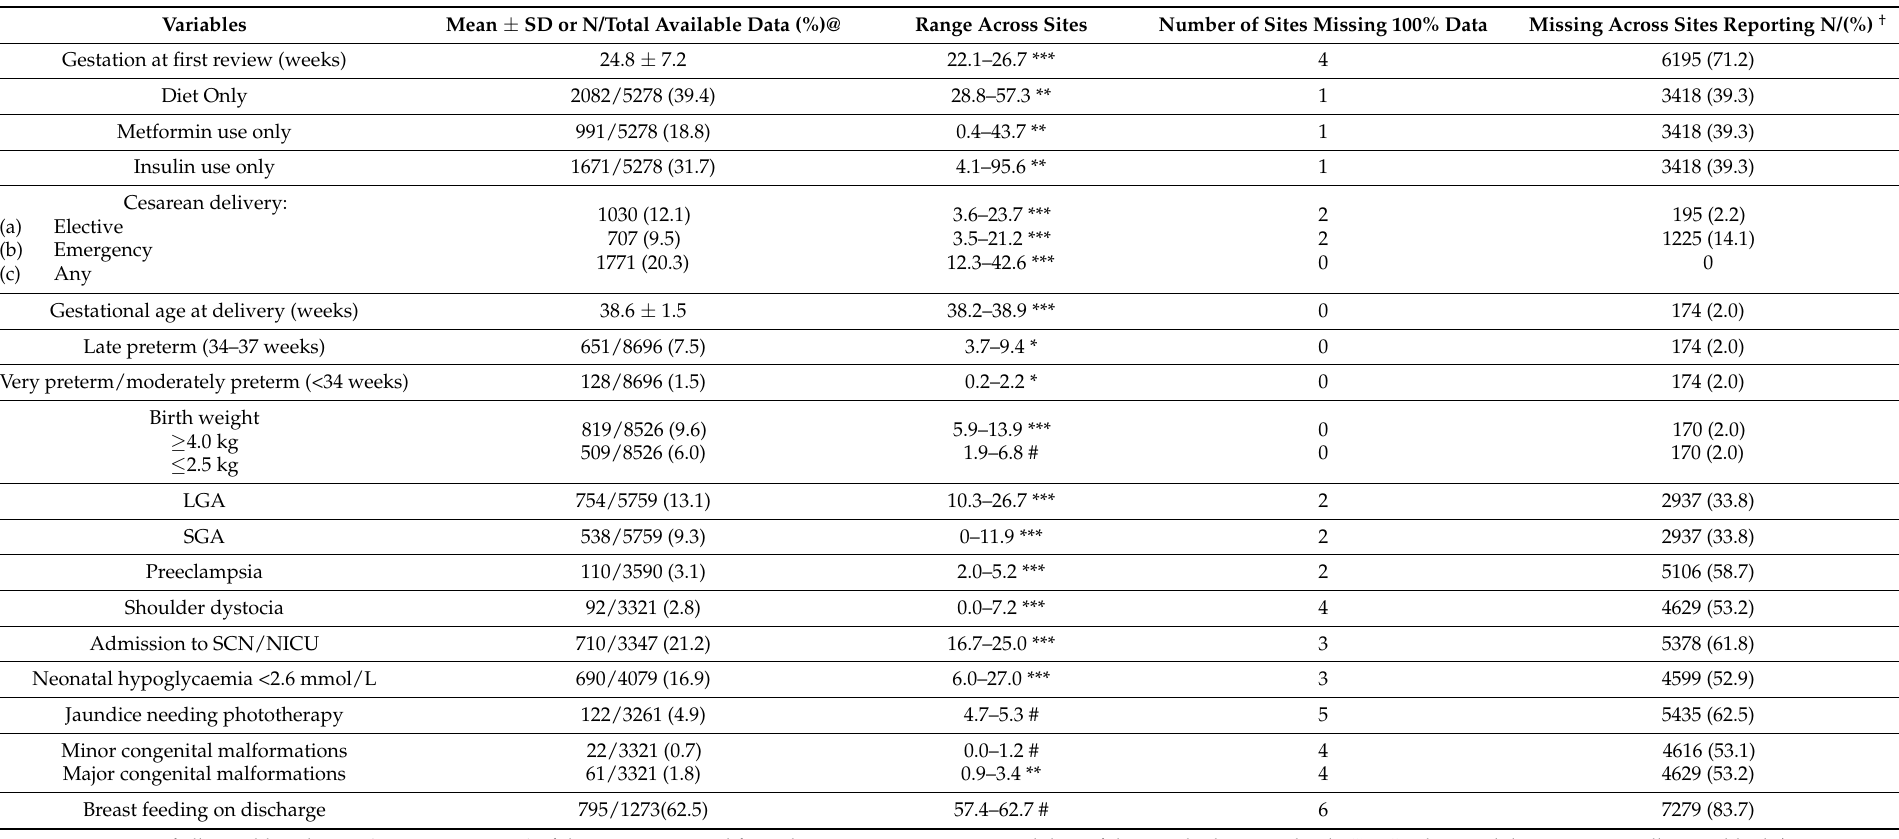
Table 4. Pregnancy care and obstetric outcomes of women with gestational diabetes